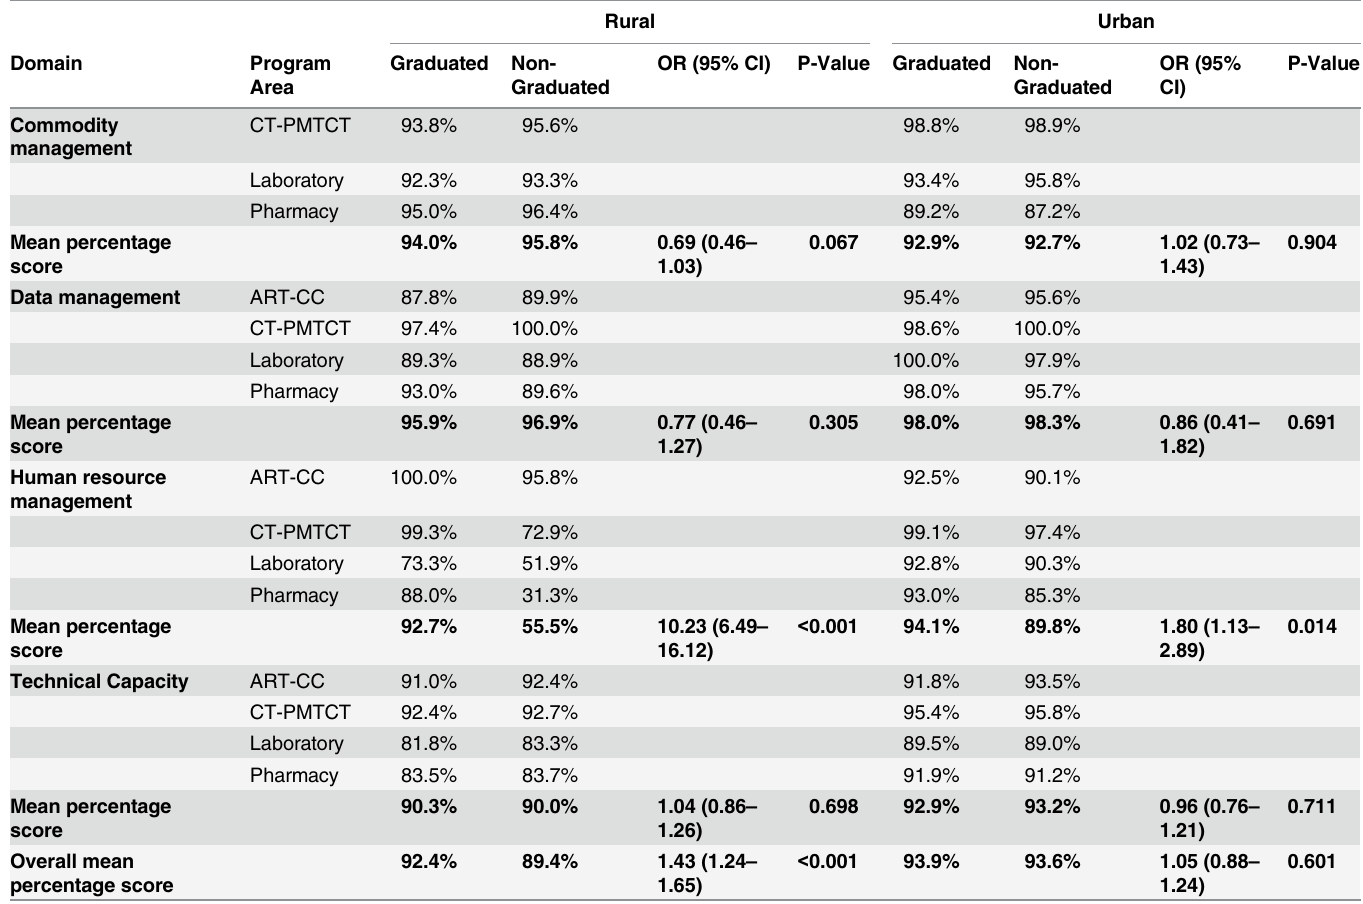
Table 4. Graduation Performance Stratified by Rural and Urban Setting.